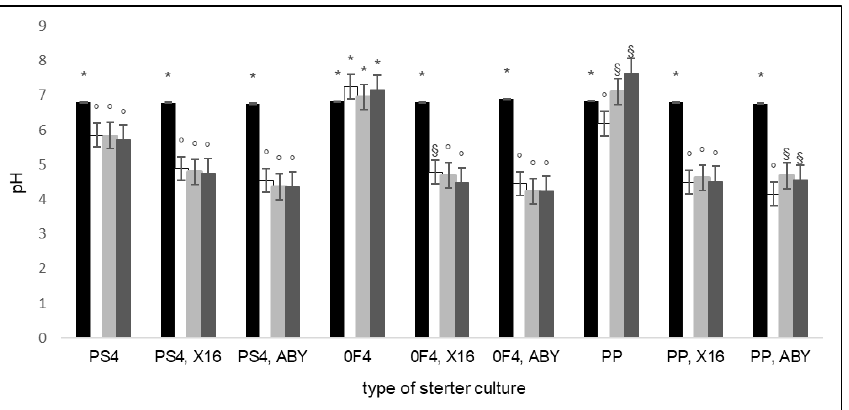
Figure 1. The changes in the pH of rice-based beverages before fermentation (black column), after fermentation (white column), after 14 days of storage (light grey column), and after 28 days of storage (dark grey column) when inoculated with different starter cultures. Within each starter cultures group means with a common symbol are not significantly different ( p ≥ 0.05). Error bars represent the standard error of the mean.